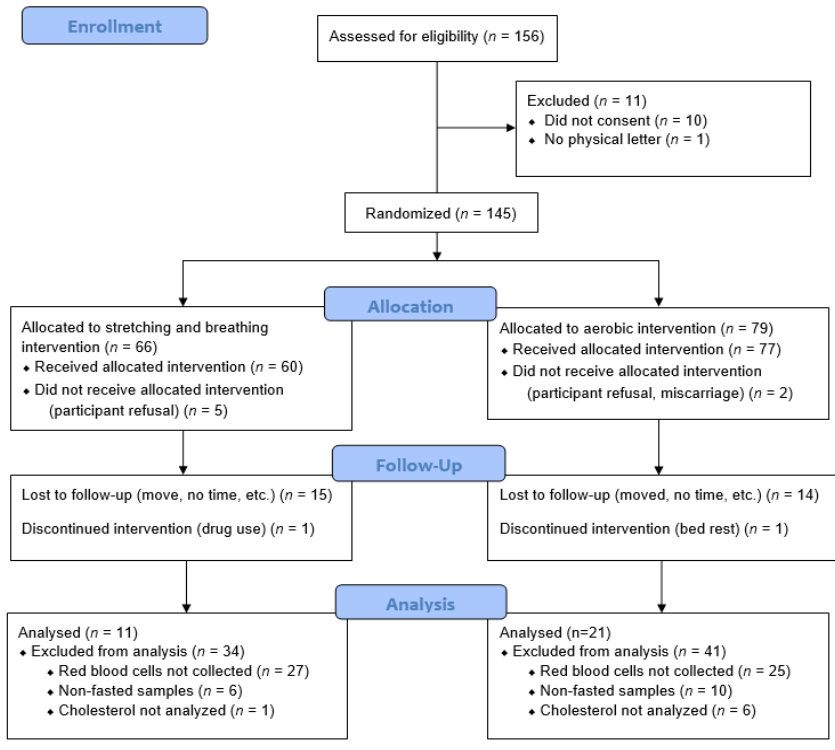
Figure 1. CONSORT diagram.